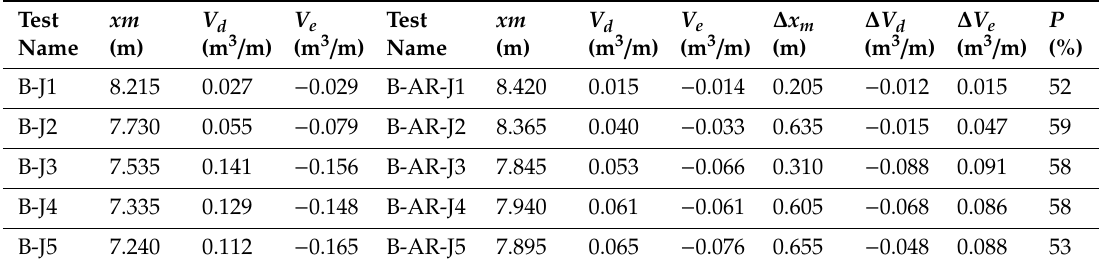
Table 5. The final volume changes of the lower and upper parts of the evolved profile relative to the initial profile under irregular waves ( xm is the intersection of the initial and final slopes; V d and V e are the volume changes of the lower and upper parts, which are positive and negative, indicating deposition and erosion; ∆ xm , ∆ V d , and ∆ V e are the di ff erence between the variables in B and B-AR tests under specific wave climate; p is the percentage of the decreased erosion volume defined as − ∆ V e divided by V e in B